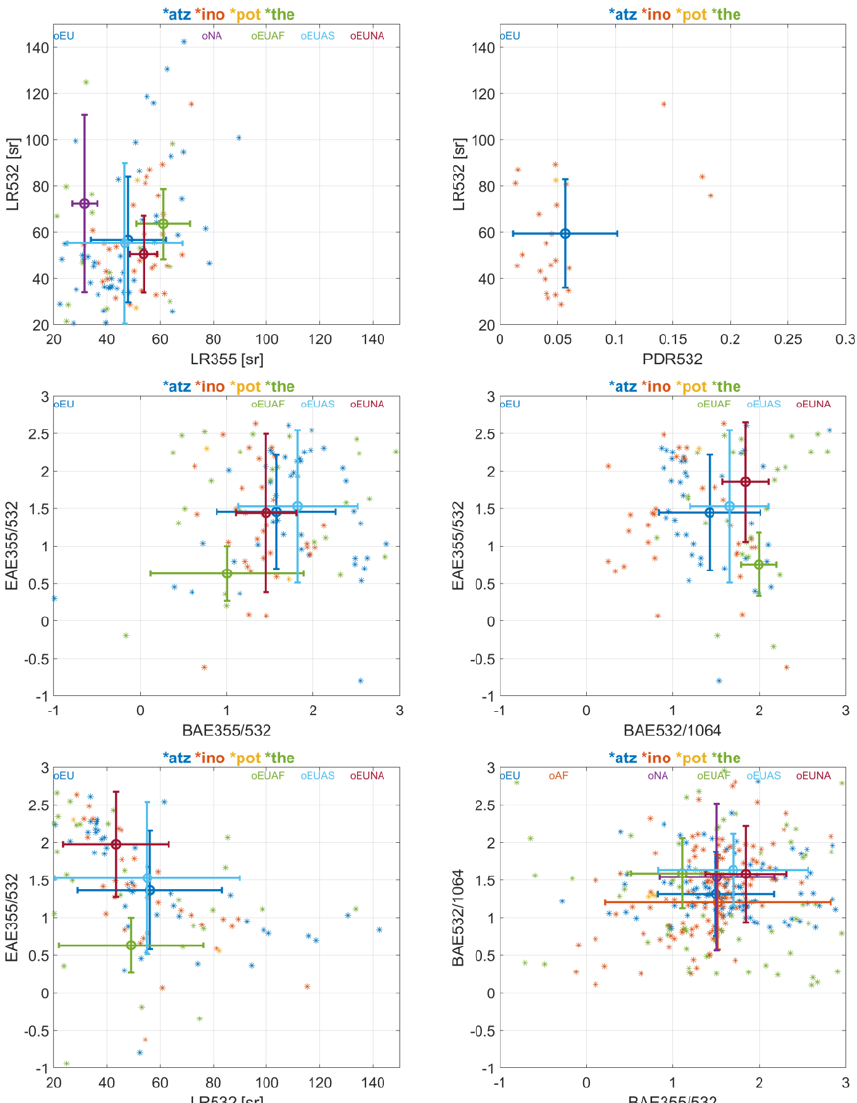
Figure 12. Scatter plots between various two intensive parameters for the south-eastern region (LR@532 versus LR@355, LR@532 versus PDR@532, EAE355/532 versus BAE355/532, EAE355/532 versus BAE532/1064, EAE355/532 versus LR@532, and BAE532/1064 versus BAE355/532). The colour code of the points is station related (as labelled in the title). The colour code for the mean and STD values is related to the source origin (as stated in the